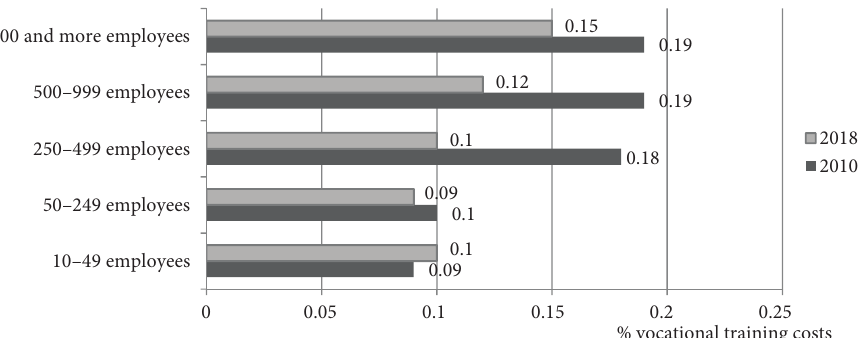
Figure 1. Share of vocational training costs per employee in enterprises with different numbers of employees (source: Own calculations based on SSSU,